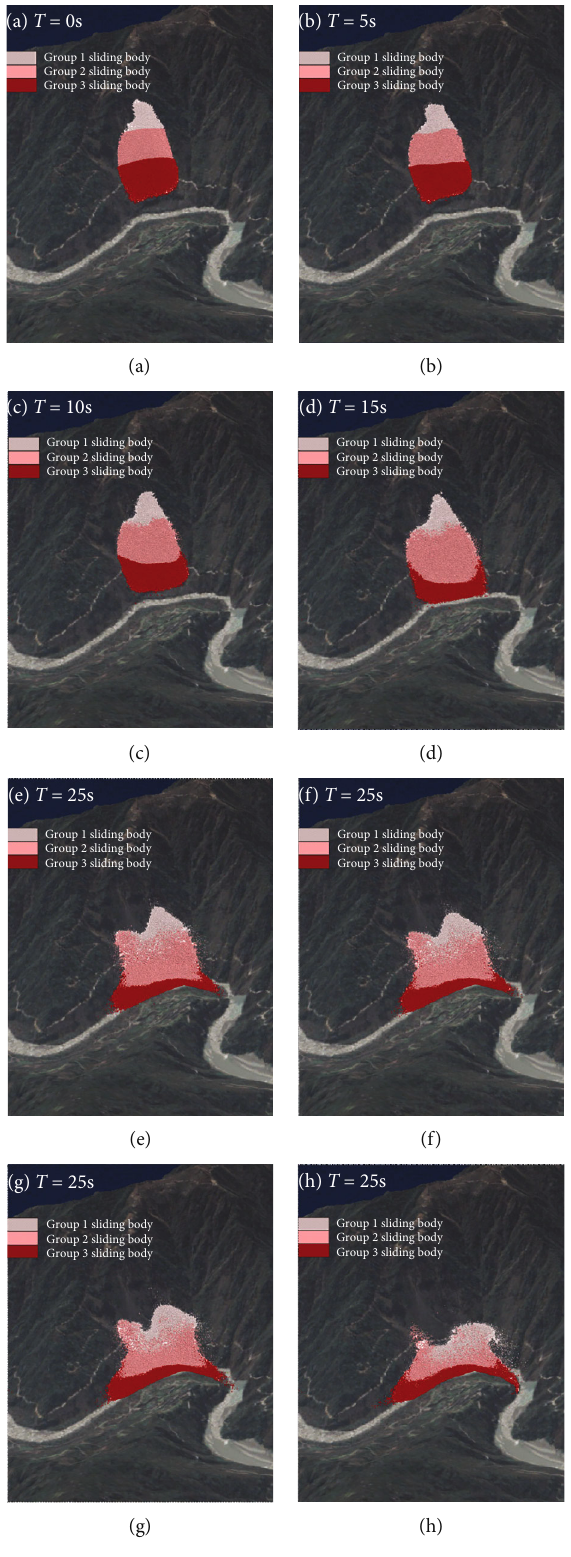
Figure 8: Tangjiashan landslide displacement pattern